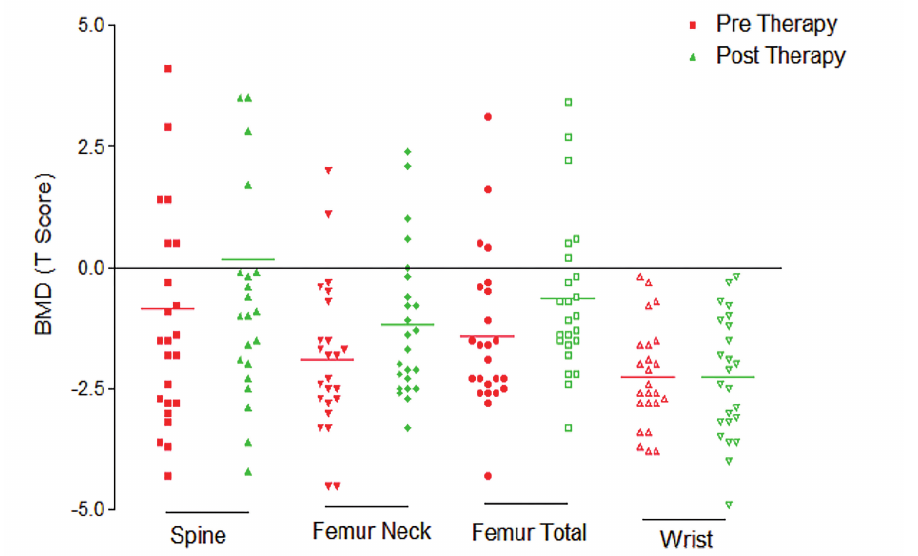
Figure 2 - Baseline and post-therapy (Zoledronic acid therapy) BMD (T-Score) showing improvement at all site except